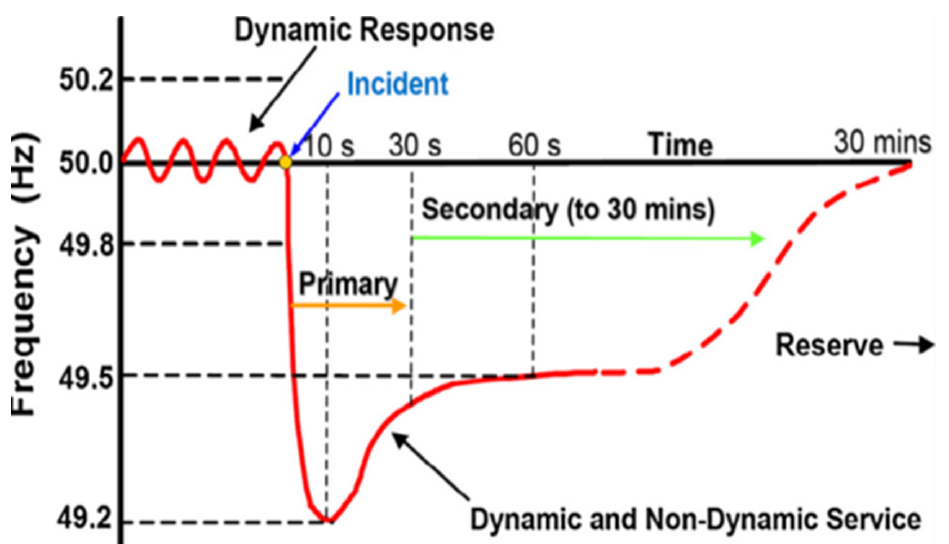
Figure 1. Frequency fluctuations following the loss of generation up to 1800 MW [1].